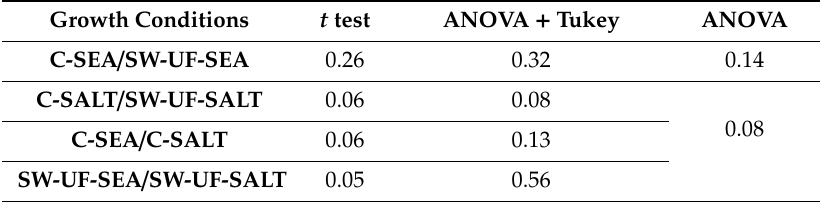
Table 2. Statistical analysis of biomass productivity for di ff erent growth conditions.